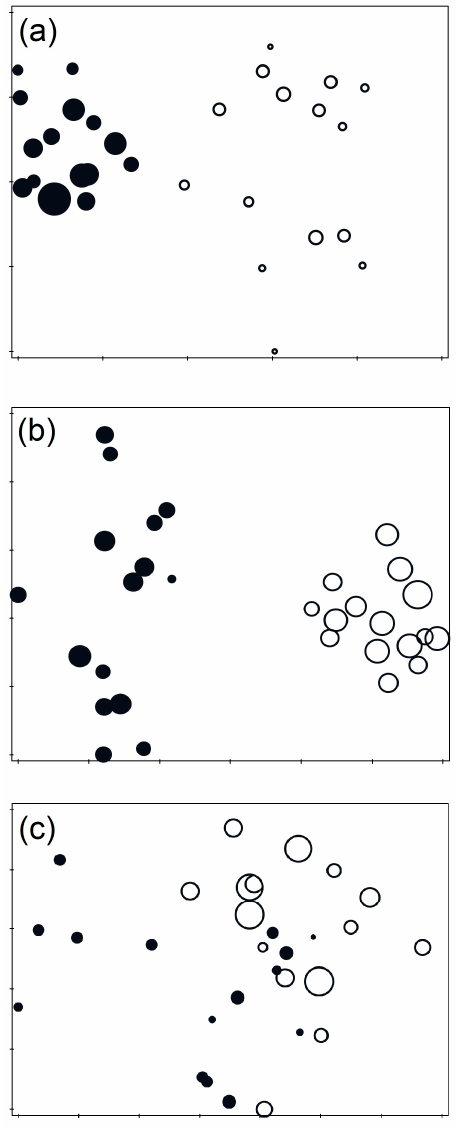
Figure 2. Detrended correspondence analysis ordination of ( a ) tree, ( b ) shrub, and ( c ) herb species in the core (filled circles) and buffer (open circles) zones in Minkong Community Forest Reserve, Nagaland, India. The comparative size of the circles represents the species richness of each plot. Table 1. Structural attributes and diversity (mean ± standard error) of trees, shrubs, and herbs in core and buffer zones of Minkong Community Reserve Forest, Nagaland, India.